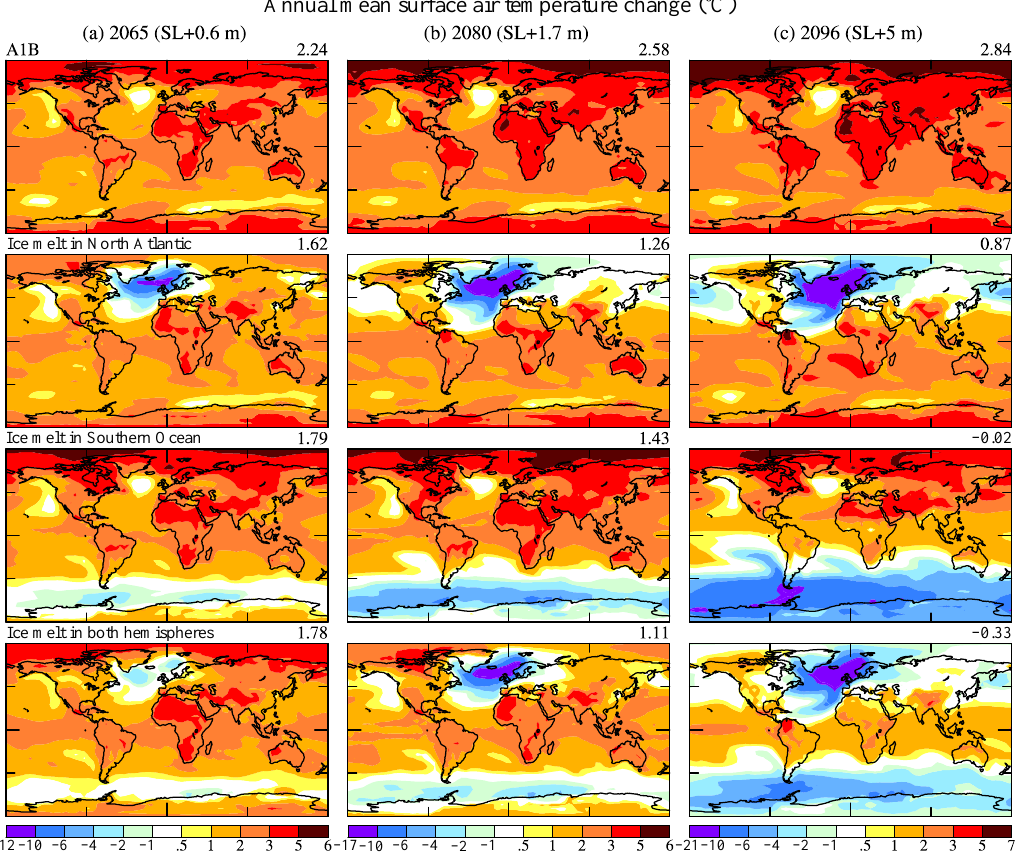
Figure 6. Surface air temperature ( ◦ C) relative to 1880–1920 in (a) 2065, (b) 2080, and (c) 2096. Top row is IPCC scenario A1B. Ice melt with 10-year doubling is added in other